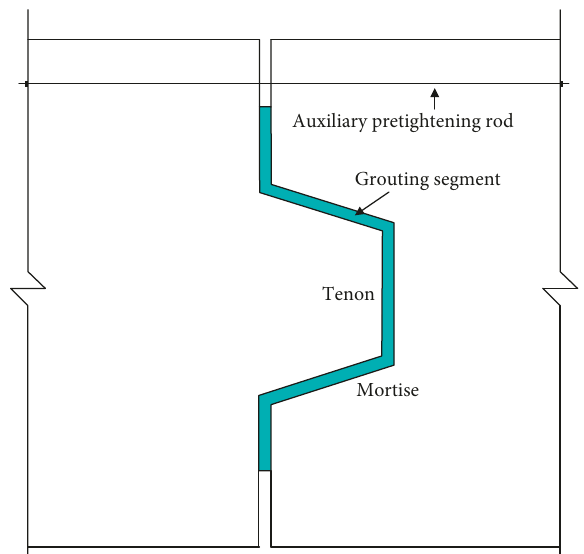
Figure 15: MT · G-Joint with an auxiliary pretightening